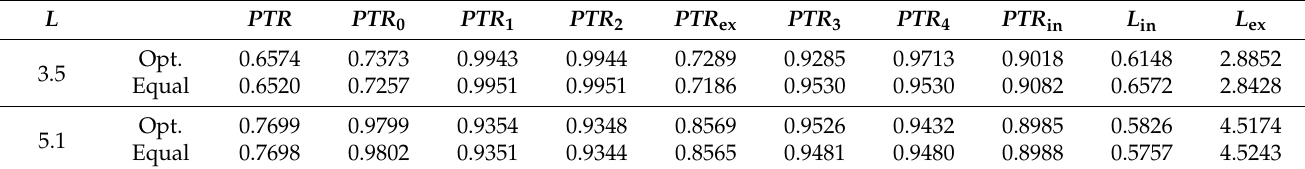
Table 2. Comparison between equal configuration intensity and optimized configuration.